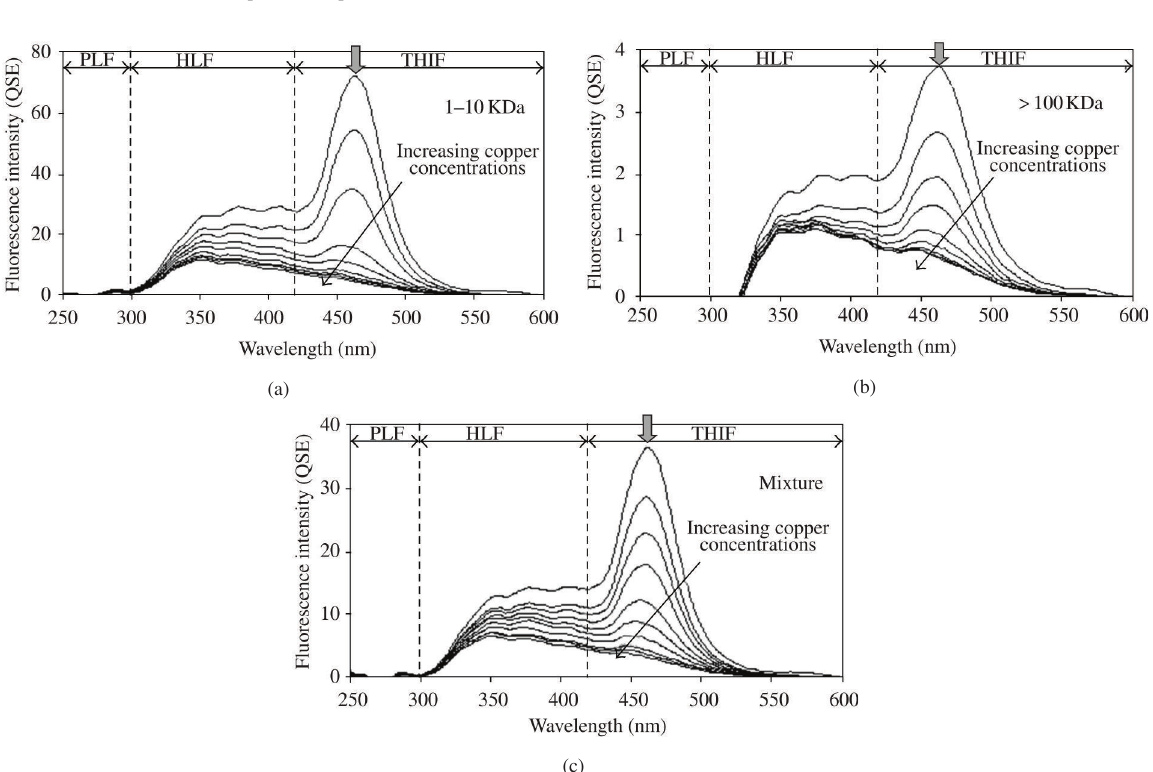
FIGURE 1: Changes in the synchronous fluorescence spectra for (a) the 1–10 KDa fraction and (b) the > 100 KDa fraction of the soil HA upon the addition of copper. The thin long arrows refer to the direction of the increasing copper concentrations. The vertical shaded arrows indicate the locations of the wavelengths for a representative peak of each